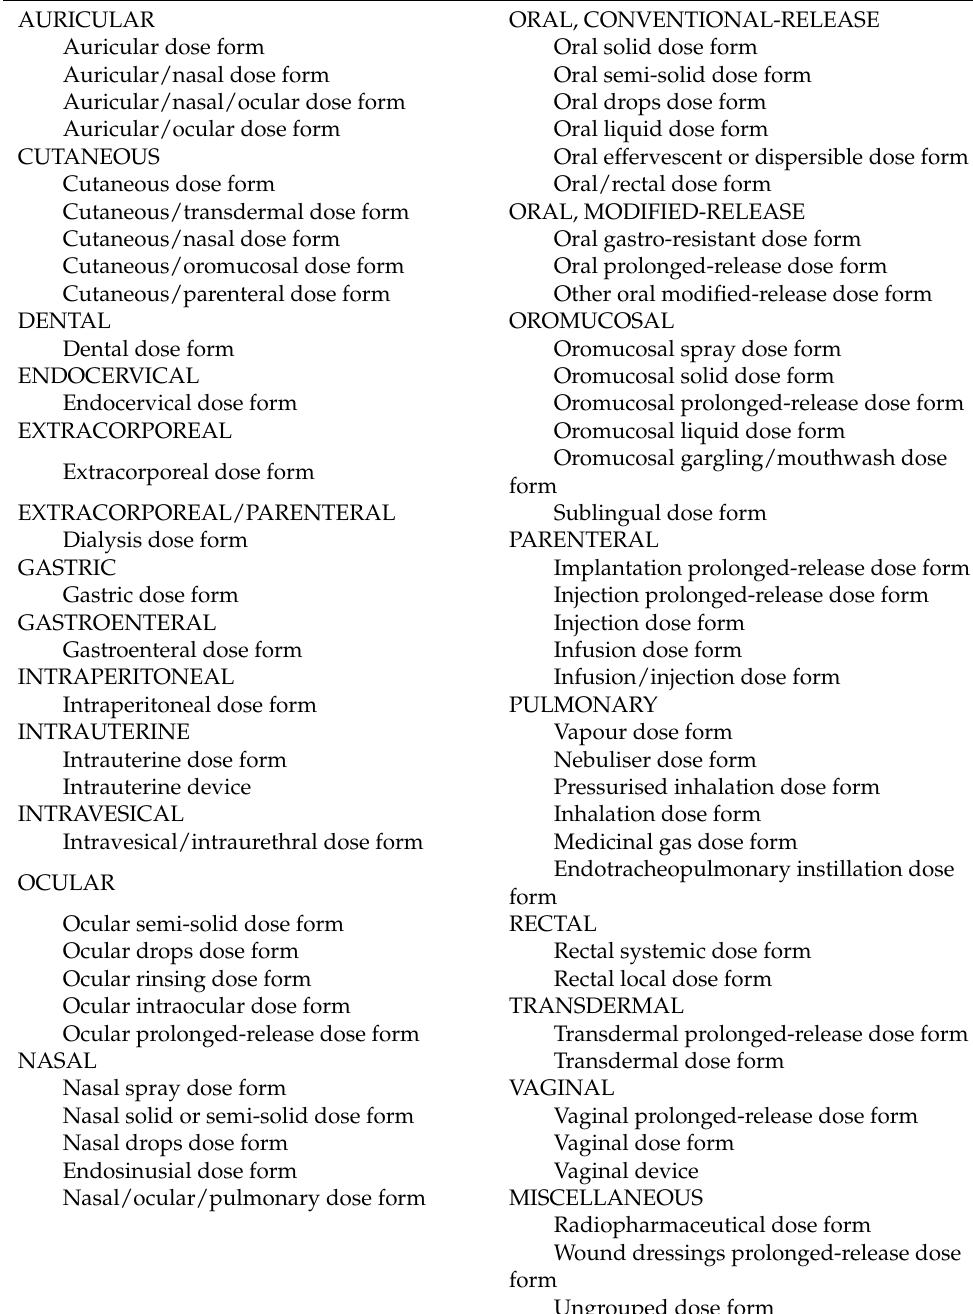
Table 2. Proposal for small ontology of dose form terminology. AURICULAR ORAL, CONVENTIONAL-RELEASE Auricular dose form Oral solid dose form Auricular/nasal dose form Oral semi-solid dose form Auricular/nasal/ocular dose form Oral drops dose form Auricular/ocular dose form Oral liquid dose form CUTANEOUS Oral effervescent or dispersible dose form Cutaneous dose form Oral/rectal dose form Cutaneous/transdermal dose form ORAL, MODIFIED-RELEASE Cutaneous/nasal dose form Oral gastro-resistant dose form Cutaneous/oromucosal dose form Oral prolonged-release dose form Cutaneous/parenteral dose form Other oral modified-release dose form DENTAL OROMUCOSAL Dental dose form Oromucosal spray dose form ENDOCERVICAL Oromucosal solid dose form Endocervical dose form Oromucosal prolonged-release dose form EXTRACORPOREAL Oromucosal liquid dose form Oromucosal gargling/mouthwash dose Extracorporeal dose form form EXTRACORPOREAL/PARENTERAL Sublingual dose form Dialysis dose form PARENTERAL GASTRIC Gastric dose form